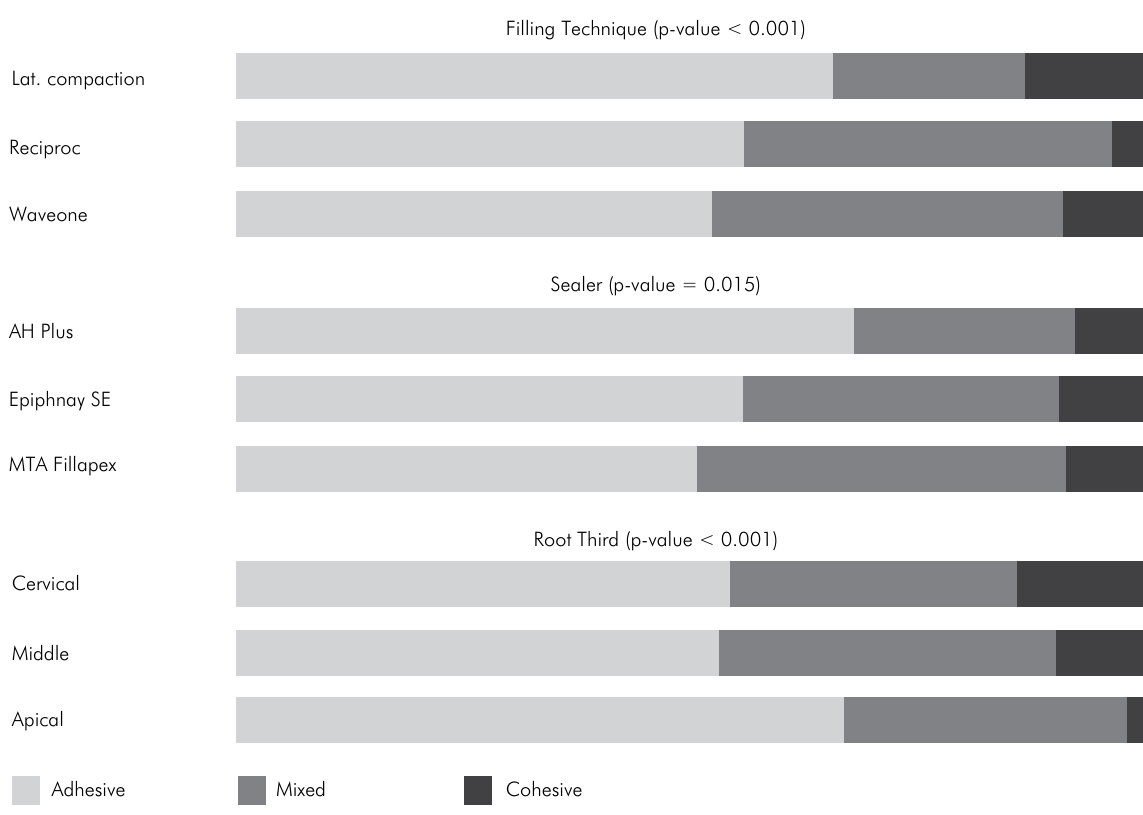
Filling Technique (p-value <